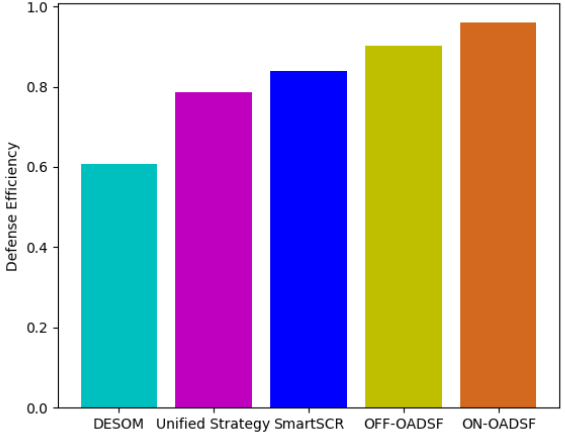
Figure 6. Defense Efficiency of different algorithms.